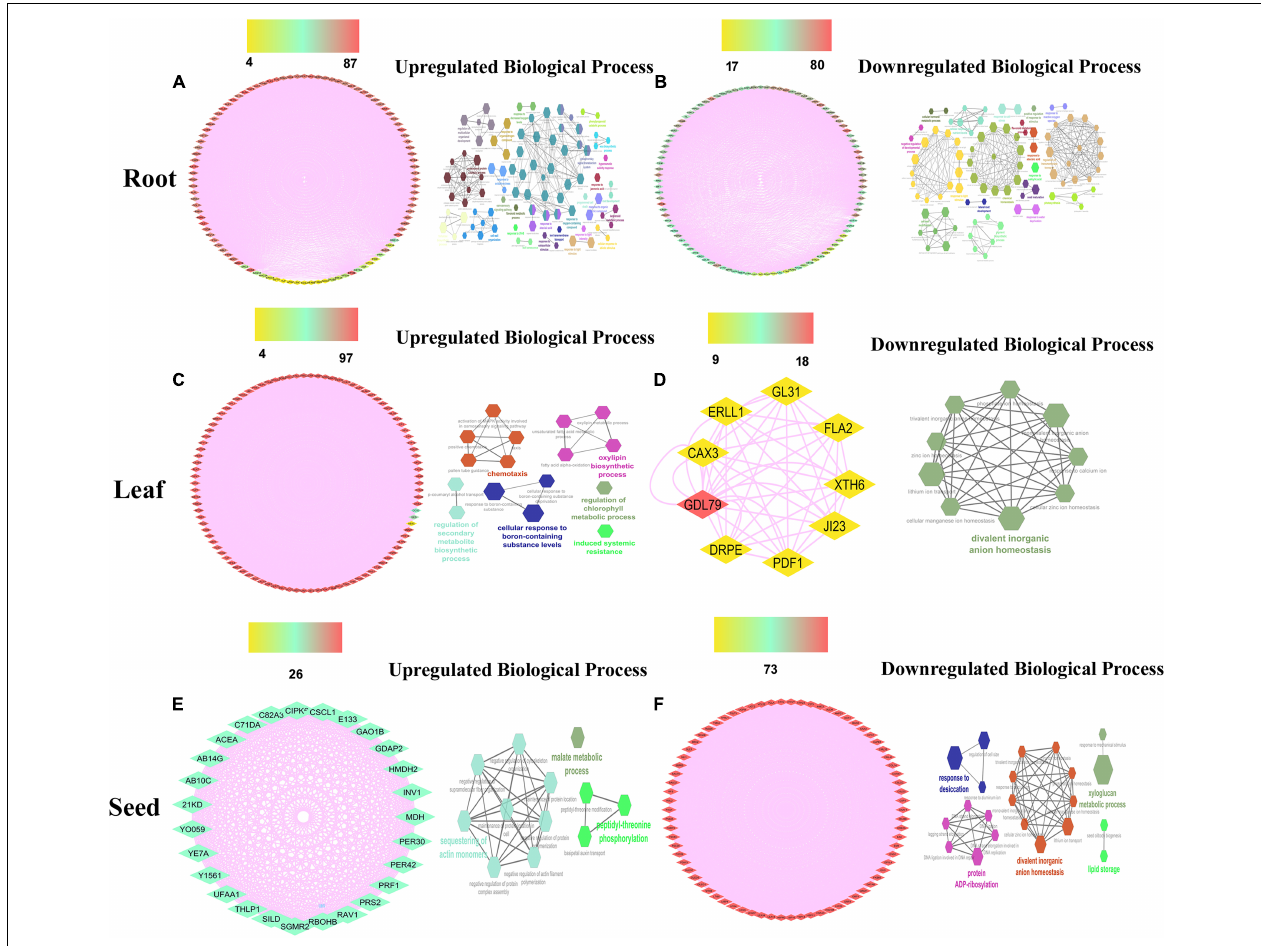
FIGURE 3 | The salt responsive genes network analysis of the top 100 upregulated (A,C,E) genes with their biological processes (B,D,F) in leaf, root, and seed tissues. Scales are showing from lower to higher degree